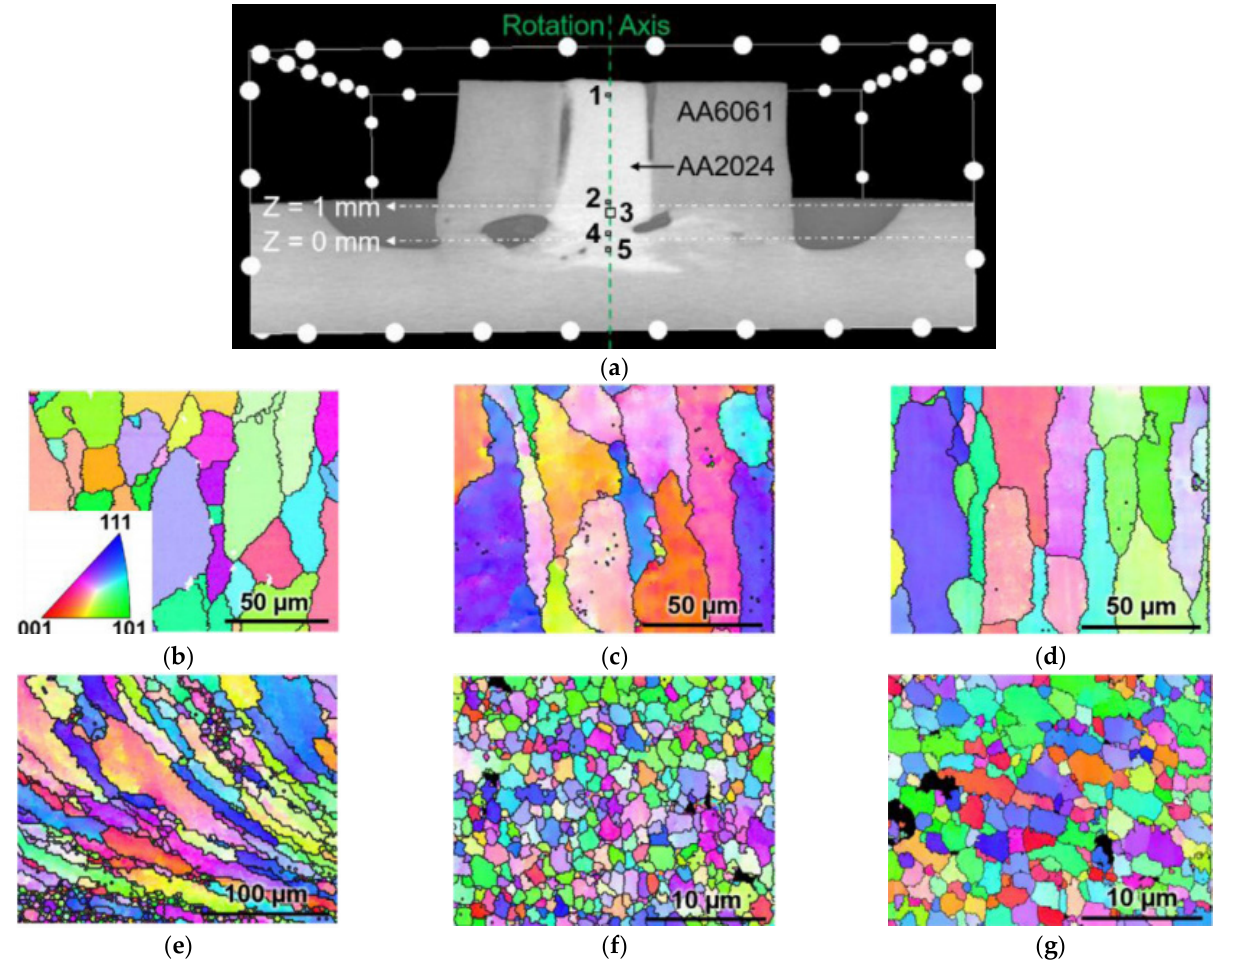
Figure 7. The possible grain evolution at the initial feeding [30]. ( a ) The cross-section with areas of interest labeled. ( b ) Base material. ( c ) Area 1. ( d ) Area 2. ( e ) Area 3. ( f ) Area 4. ( g ) Area 5.